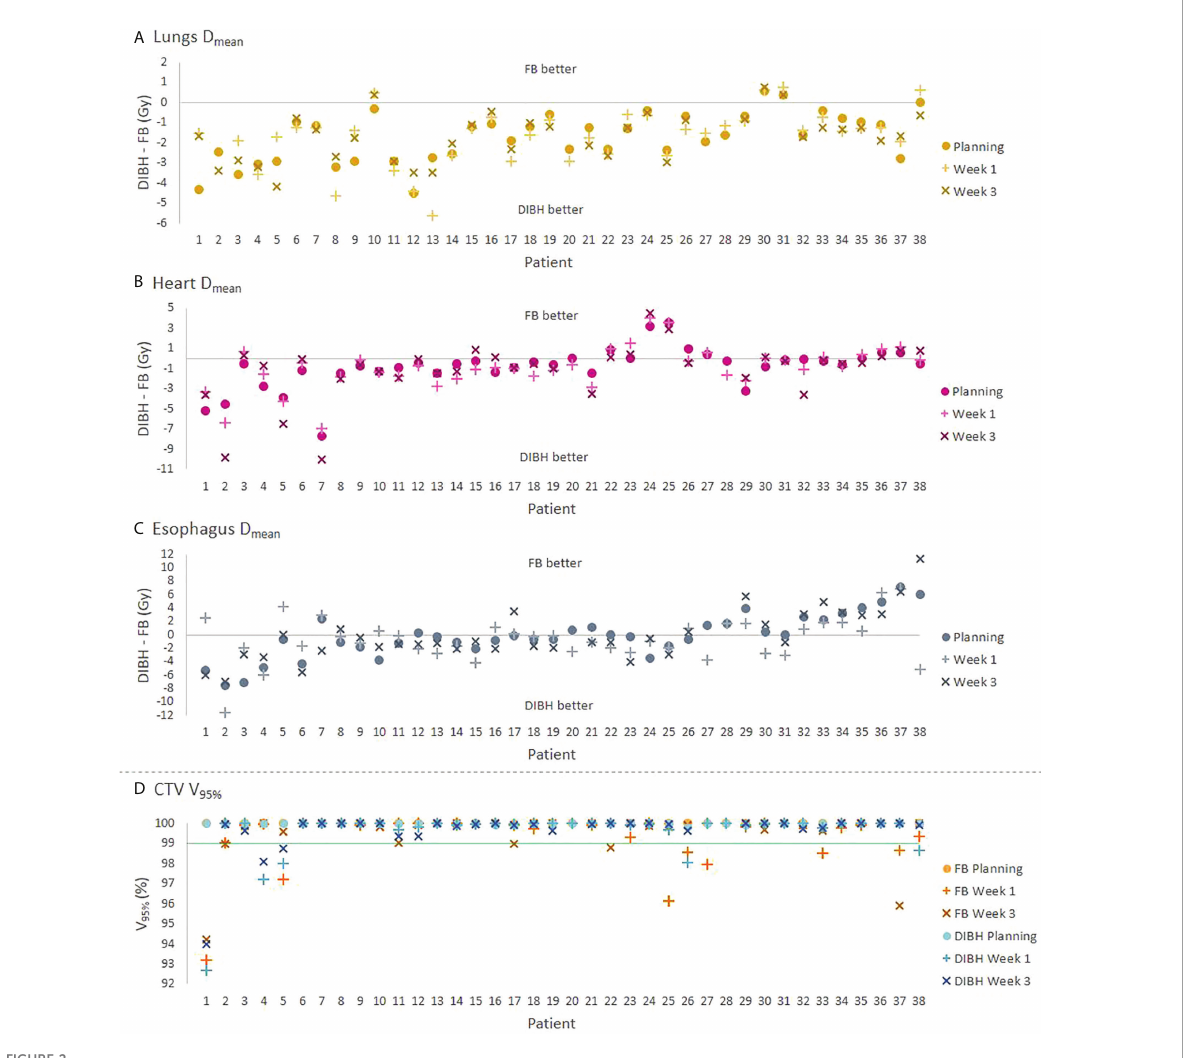
FIGURE 2 (A – C) Absolute differences in D mean for the lungs, heart and esophagus between the DIBH and FB plans for each patient. (D) CTV V 95% for each technique, with the green line indicating the required value of 99% for the rCTs. The values at planning, W1 and W3 are represented by different symbols. For three patients where a W3 rCT was not available (patients 20, 27 and 28), results are shown only for the other time points. The patients are sorted according to the sum of DIBH-FB differences for the OARs at